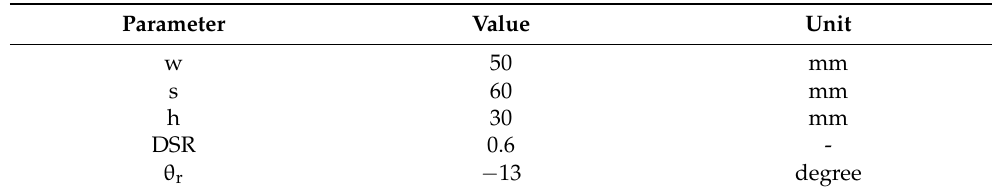
− 13 degree With the values in Table 8, D x , S d , S b , and S h for six walking cycles (6T) were obtained as 709.2 mm, 711, 581, and 0, respectively, and the reward value calculated by Equation (34) was obtained as 12,711. The saved weights were loaded and tested in the Webots R2020b simulator. The walking trajectories obtained with the optimized gait parameters were visualized with graphs in MATLAB R2021b for the gait cycle. The three-dimensional representation of the walking model is given in Figure 18.